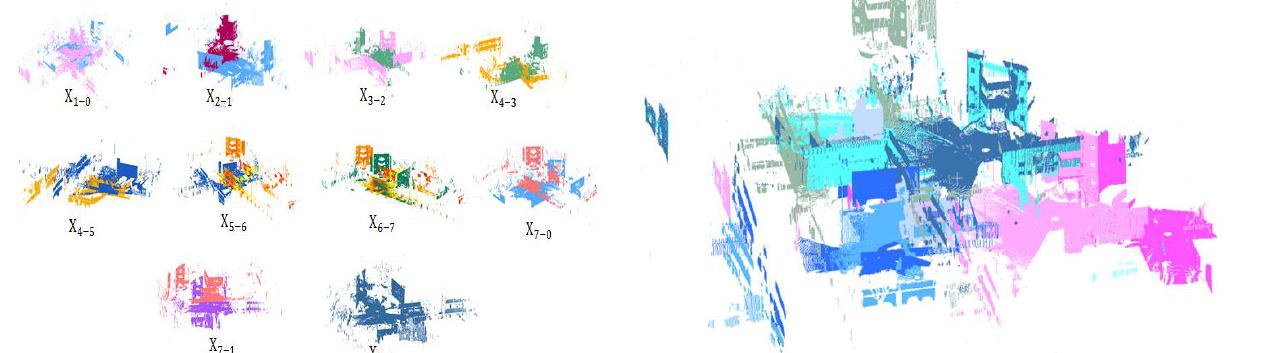
Figure 7. Globally consistent TLS